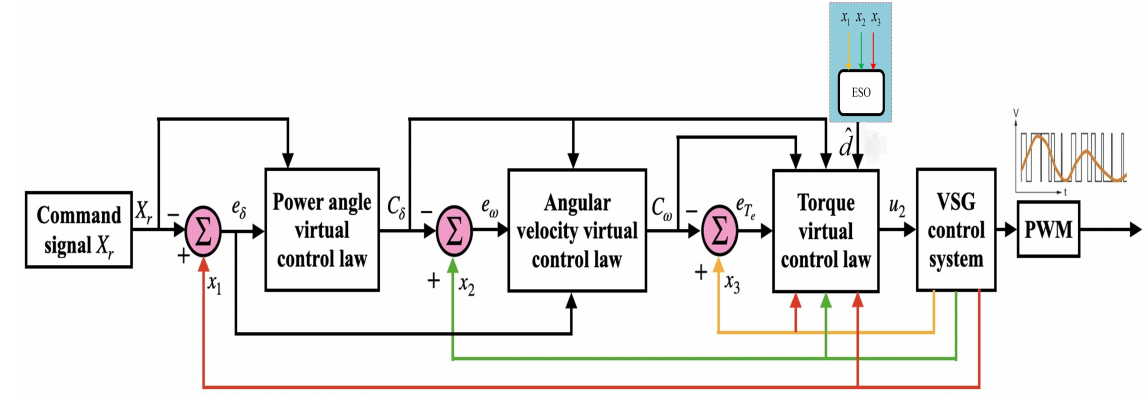
Figure 4. Structure of backstepping controller combined